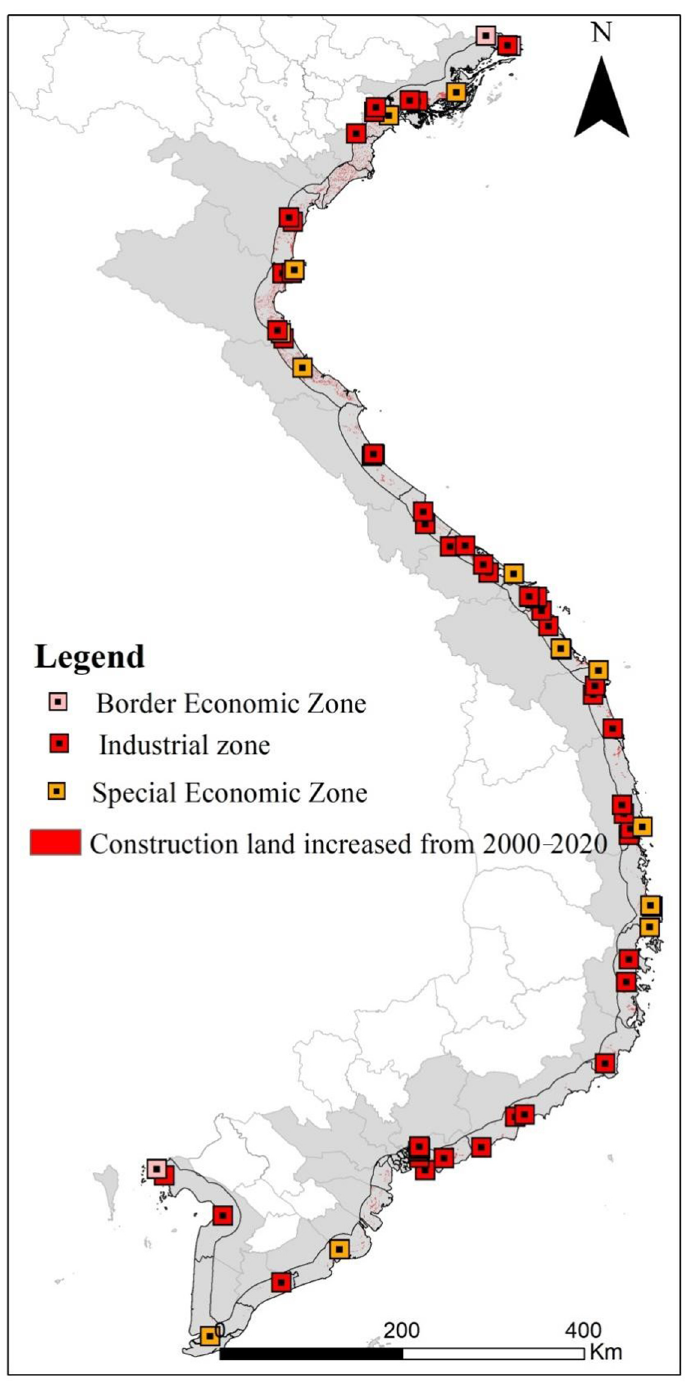
Figure 9. Distribution of coastal industrial